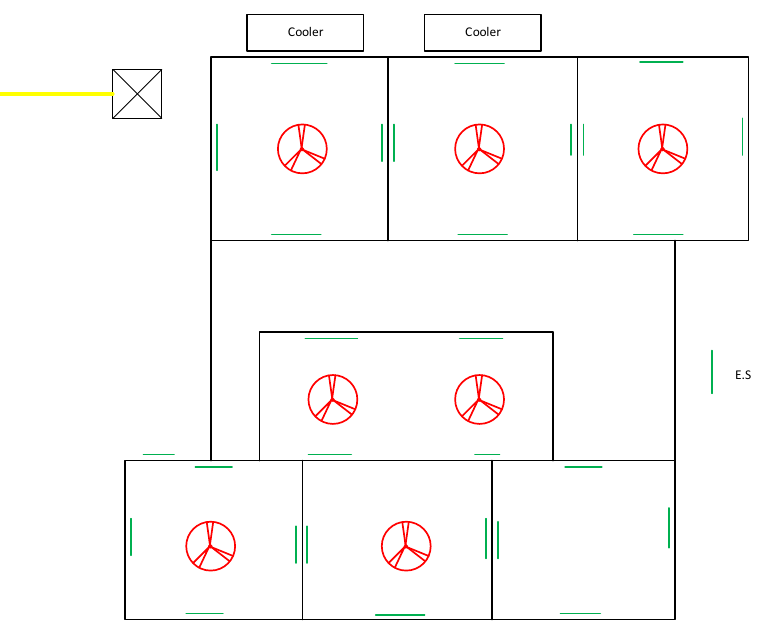
Figure 16. Staff hostel